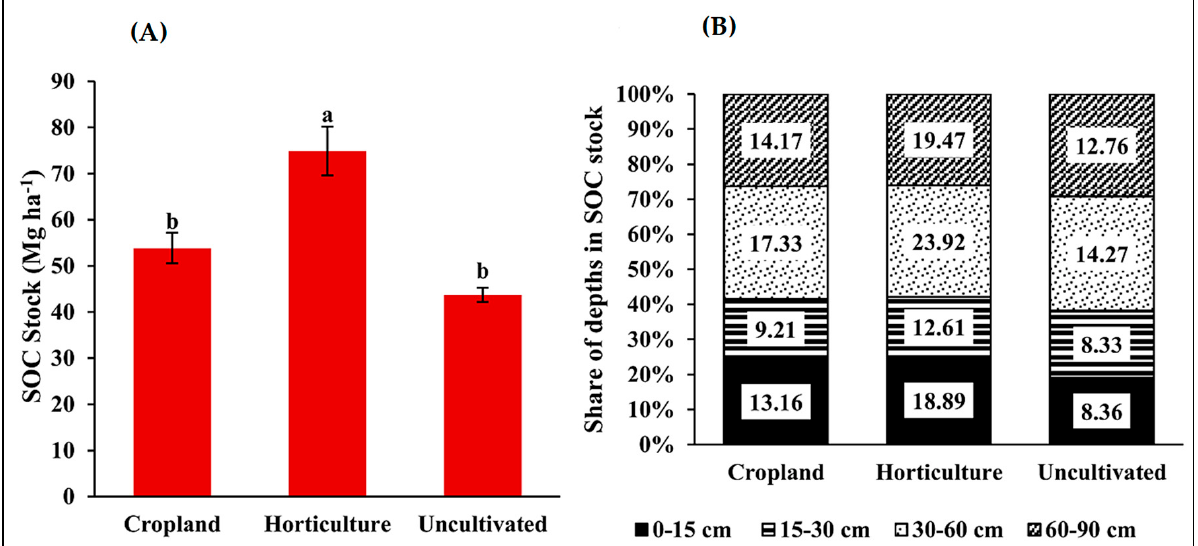
Figure 1. ( A ) Soil organic carbon (SOC) stock (Mg ha − 1 ) of the studied soil profile (up to 90 cm depth) and ( B ) its distribution in four studied soil depths (0–15, 15–30, 30–60, 60–90 cm) under different land uses expressed in terms of percentage of total SOC stock (Vertical bars indicate standard errors of means; dissimilar letters indicate significant differences at p ≤ 0.05).